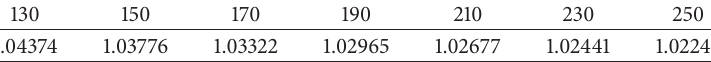
Table 3: Relationship between the number of discrete frequencies 𝑚 and the constant 𝐶